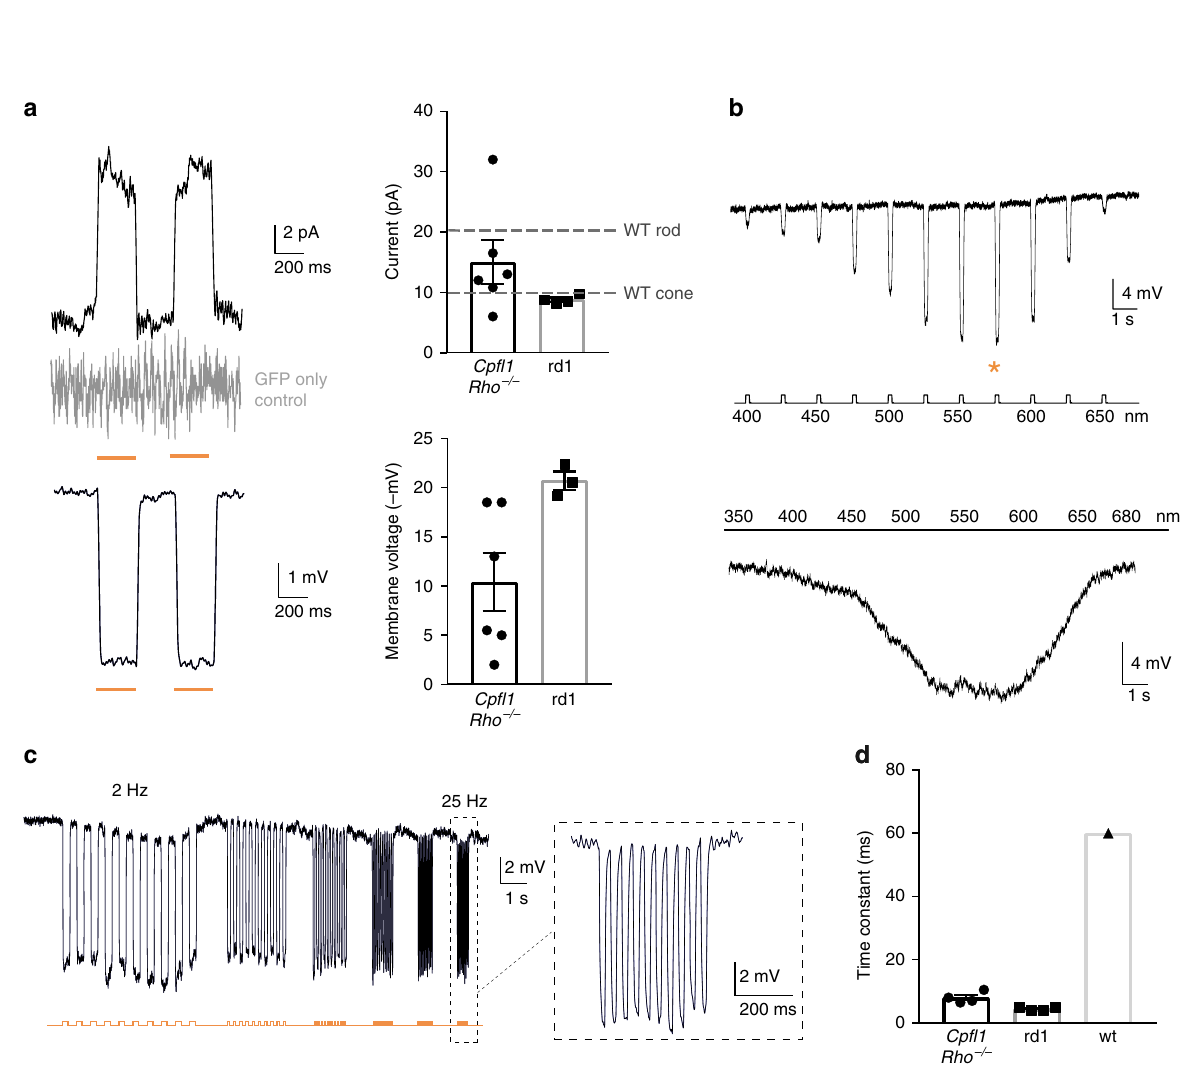
Fig. 1 Transplanted photoreceptor precursors, expressing NpHR, integrate into the retina of blind mice. a Eyes of wild-type mice at P2 were injected with AAV-Rho-NpHR-YFP. Two days later, retinas were dissected and photoreceptor precursors sorted out. These cells were transplanted via sub-retinal injections into blind mice. b – g Immuno fl uorescence analysis on vertical sections of Cp fl 1/Rho − / − ( b – d ) and rd1 ( e – g ) retinas. b Age-matched non- transplanted Cp fl 1/Rho − / − retina. c , d Cp fl 1/Rho − / − retina transplanted with NpHR-photoreceptors showing NpHR-YFP + cells (stained with anti-GFP antibody, green) located on top of host PKC α bipolar cells (red). e Age-matched non-transplanted rd1 retina. f , g Rd1 retina transplanted with NpHR- photoreceptors. h , i Y chromosome FISH. h A retinal section showing Y chromosome labelling (magenta) and immunohistochemistry staining for GFP (green) with DAPI counterstaining (white) 4 weeks after transplantation of NpHR-expressing rods from male donors into a female Cp fl 1/Rho − / − mouse (P60 at the time of transplantation). i Quanti fi cation of NpHR-expressing cells containing Y chromosome from fi ve individual experimental retinas ( N = 5). The vast majority of NpHR-YFP + cells (stained with anti-GFP antibody) also contained a Y chromosome (90.9 ± 1.2%), proving that they originate from donor mice Values are mean ± SEM with corresponding data points overlaid. Error bars are SEM. Source data are provided as a Source Data fi le. Scale bars are 25 μ m. SRS — subretinal space, OPL — outer plexiform layer, INL — inner nuclear layer, GCL — ganglion cell layer, P — postnatal day